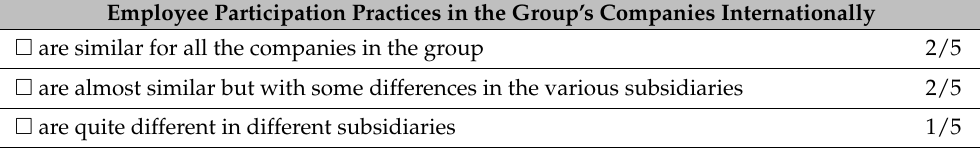
Table 4. Similarities and differences of employee participation practices in the group of companies internationally.